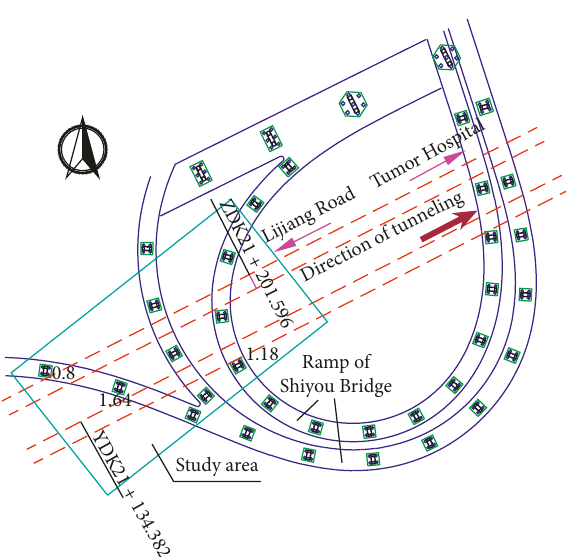
Figure 2: Location of pile groups and shield tunnel (unit: m).